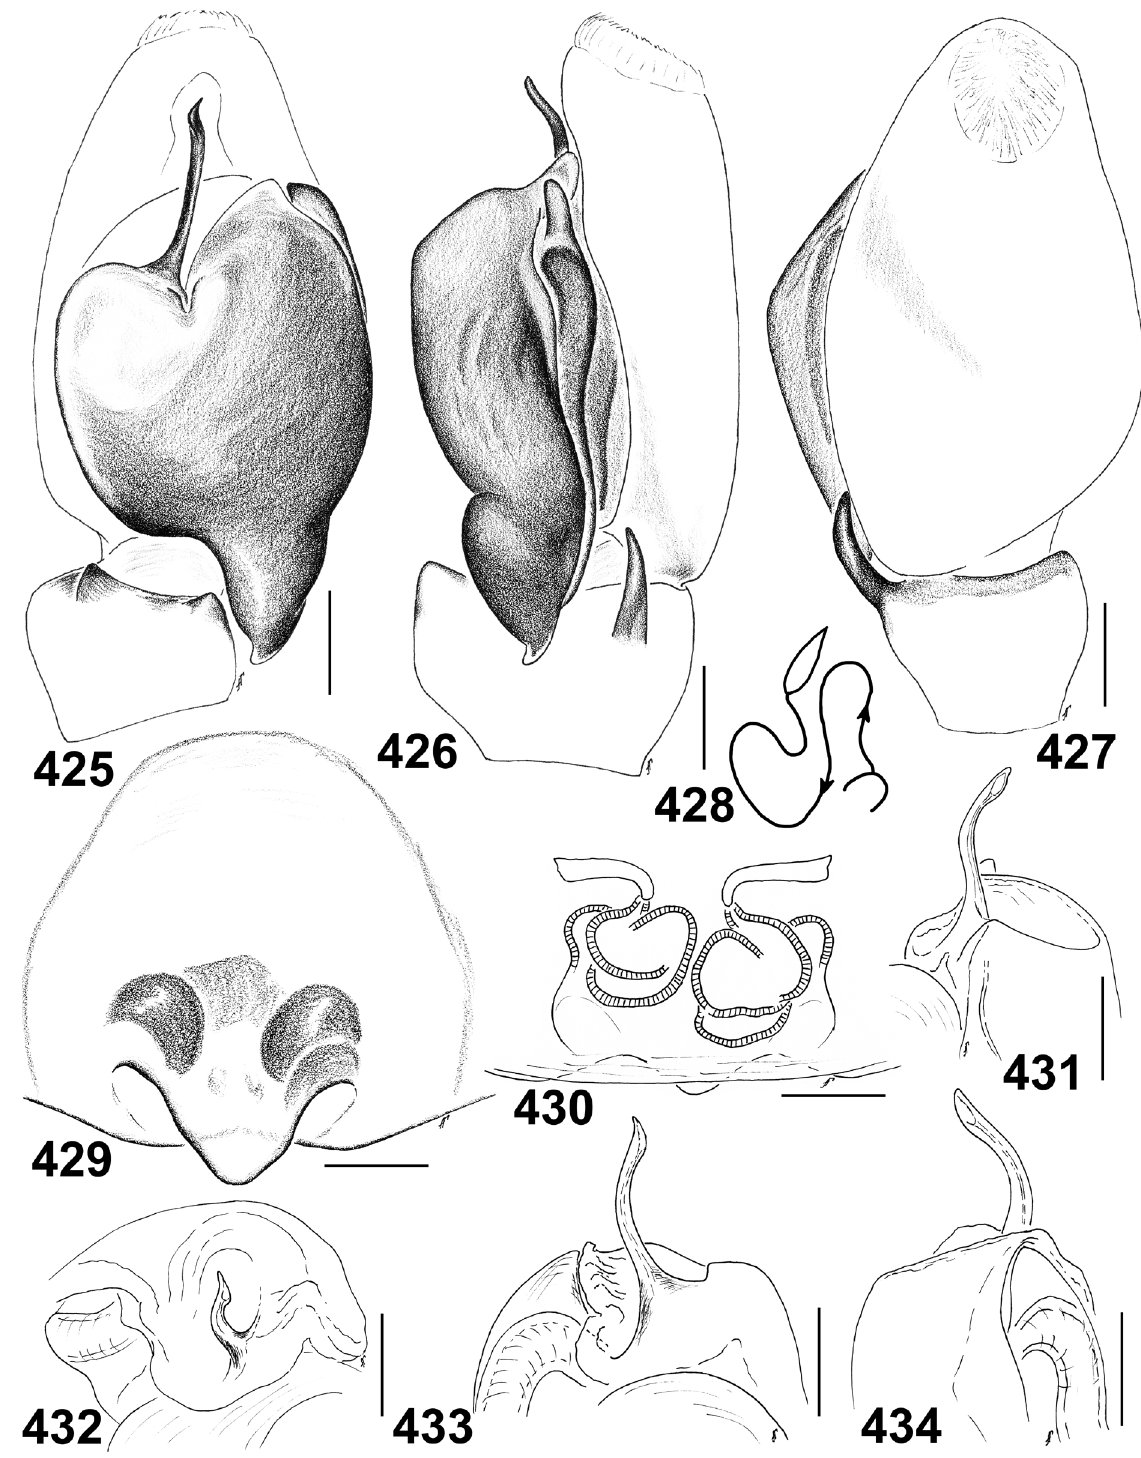
Figs 426–434. Stenaelurillus senegalensis sp. nov., holotype, ♂ (425–427) and paratypes (428–434) . 425–427 . Male palp. 425 . Ventral view. 426 . Retrolateral view. 427 . Dorsal view. 428 . Diagrammatic course of the insemination ducts. 429 . Epigyne, ventral view. 430 . Spermathecae, dorsal view. 431– 434 . Embolic division. 431 . Median view. 432 . Apical view. 433 . Dorsal view. 434 . Retrolateral view. Scale bars: 0.1